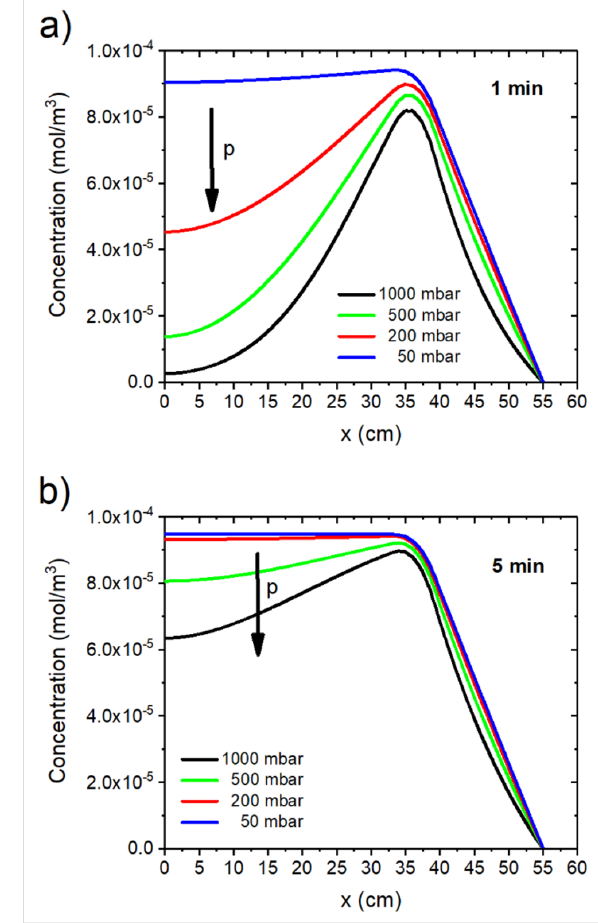
Figure 4: Process pressure dependence of the metal vapor concentra- tion along the quartz tube: simulated metal vapor concentration for a variation of the simulated process pressure after (a) 1 min and (b) 5 min. The simulated volumetric flow rate (from the right) is 100